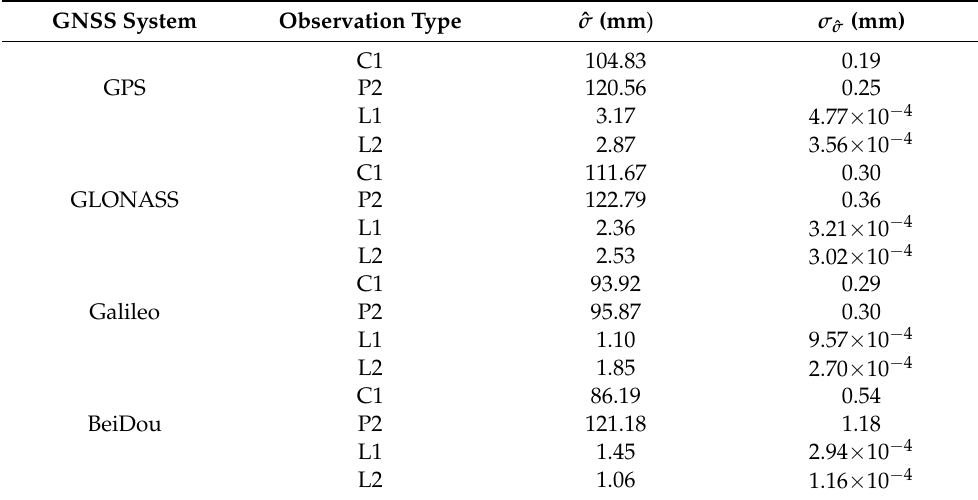
Table 4. Standard deviation of the phase and code observations and their precision for each system for LEICA GR30 receiver over a very short baseline.